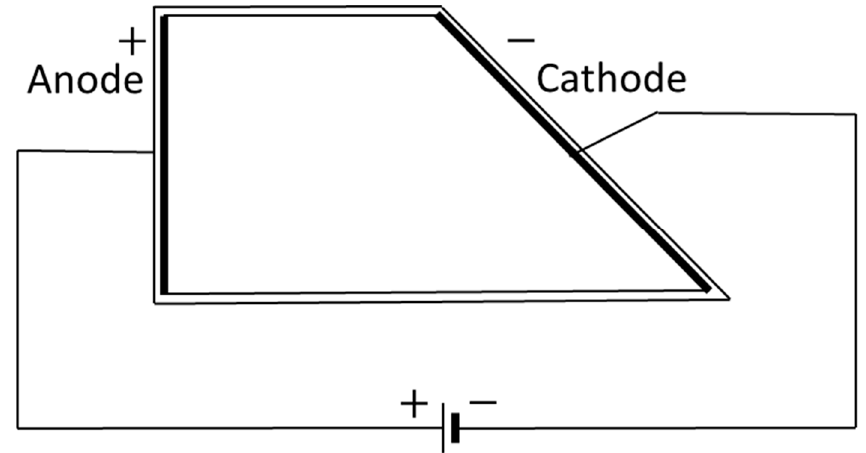
Figure 2. Electric circuit of a rectangular Hull cell. The anode and cathode panels are depicted in thicker lines.